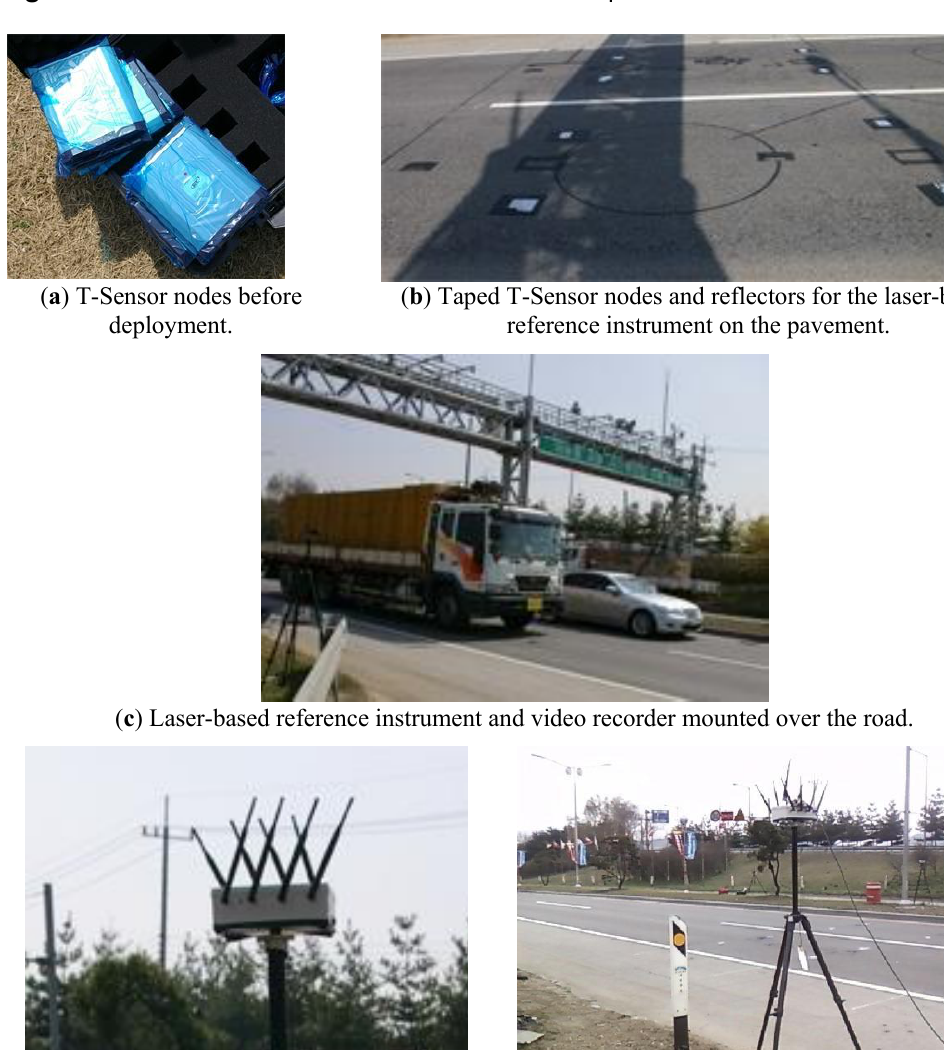
Figure 12. PES under evaluation in the KICT ITS performance evaluation